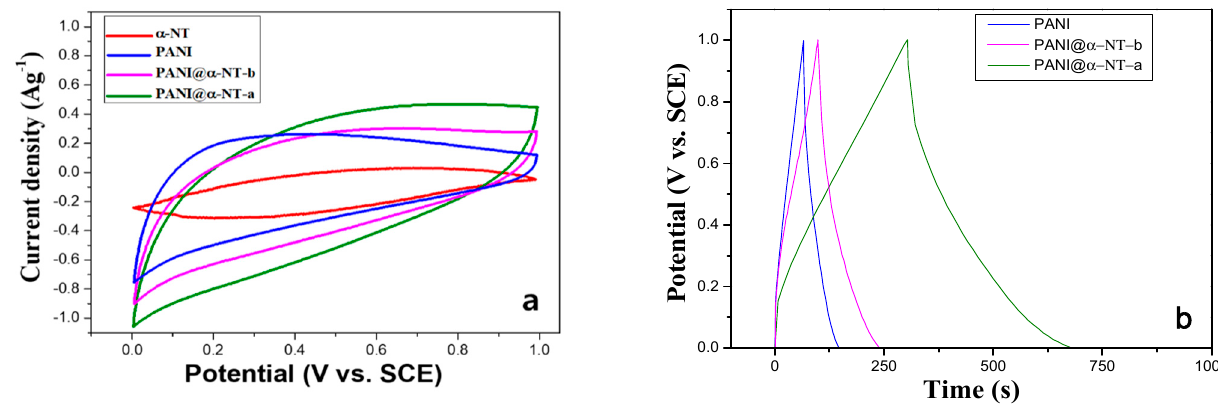
Figure 5. ( a ) Cyclic voltammograms of PANI@ α -NTs and PANI. ( b ) Galvanostatic charge–discharge behavior of PANI@ α -NTs and PANI at 0.5 Ag − 1 current density. Table 1. Specific capacitance of PANI@ α -NTs, α -NTs and PANI at different current densities. Electrode